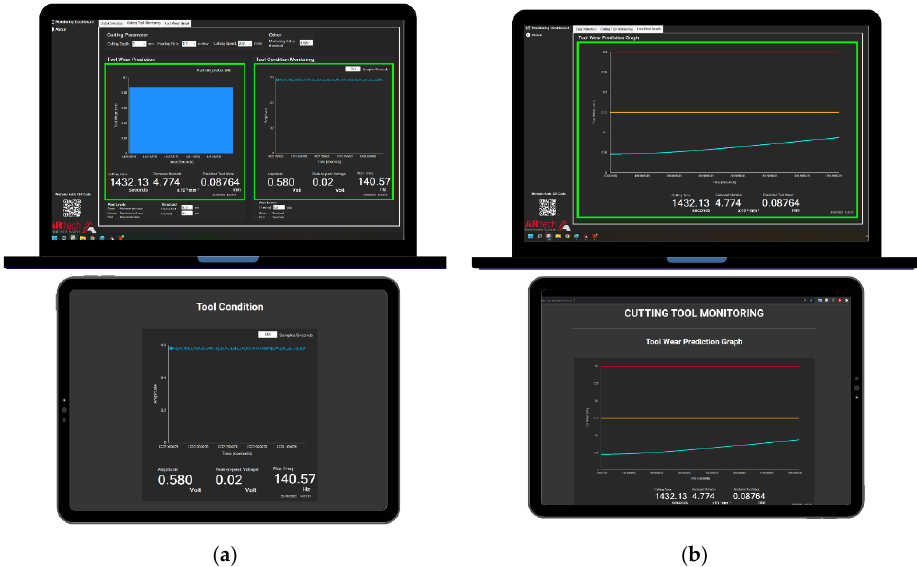
Figure 18. CPMA application in revisualized parameter prediction result: ( a ) first appearance and ( b ) second appearance. ( b ) second